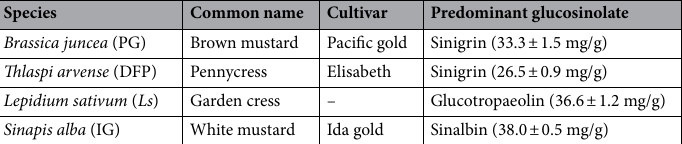
Table 1. Glucosinolate concentration in ground defatted seed meals after Soxhlet extraction.